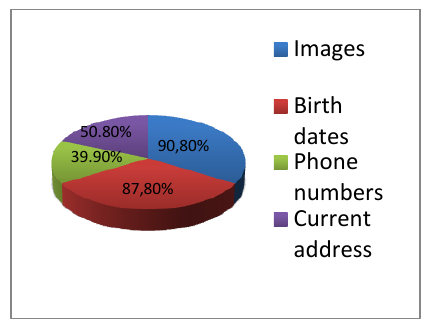
Figure 3. User disclosed information in